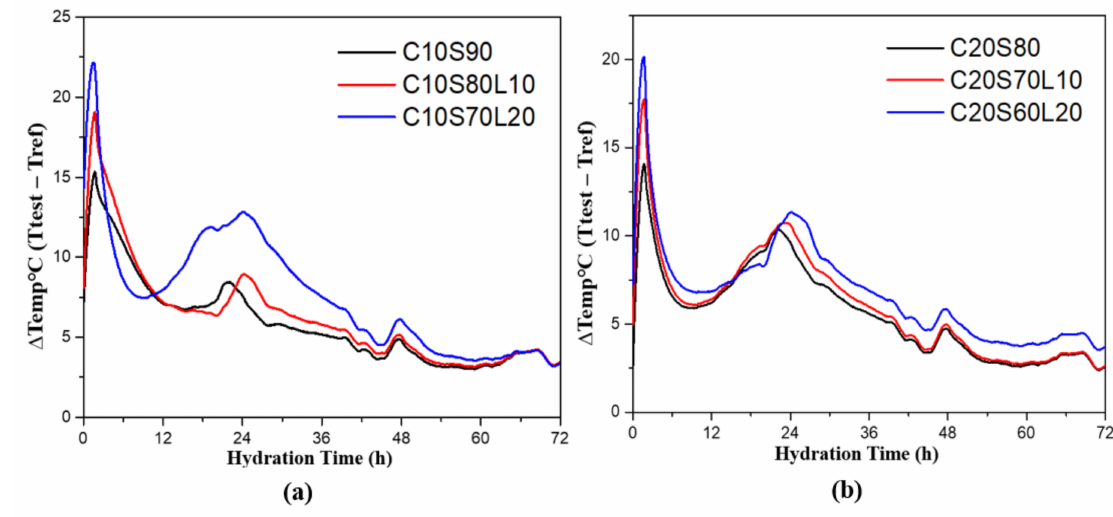
Figure 5. Calorimetric curves for the rate of heat release for ( a ) 10%, and ( b ) 20% OPC-containing AAS mixtures.